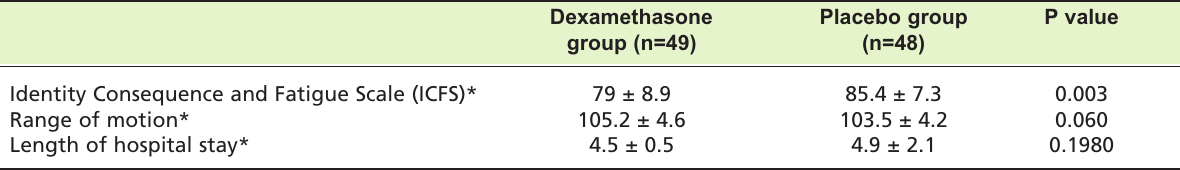
Clinical effects and complications encountered after anterior cruciate ligament Table IV: